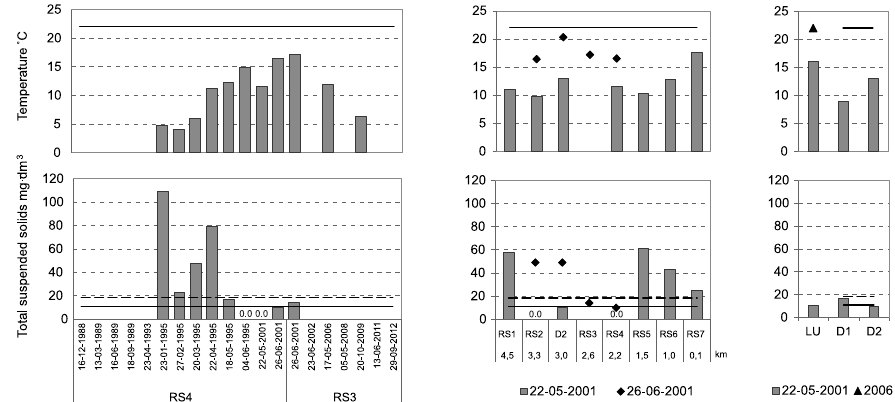
Fig. 6. Physical indicators of surface waters: temperature and total suspended